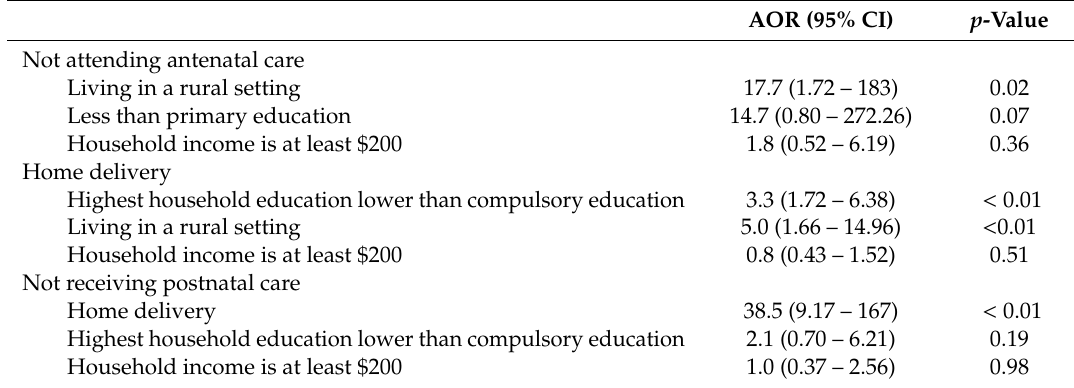
Table 6. Adjusted odds ratio (AOR) for determinants of maternal health